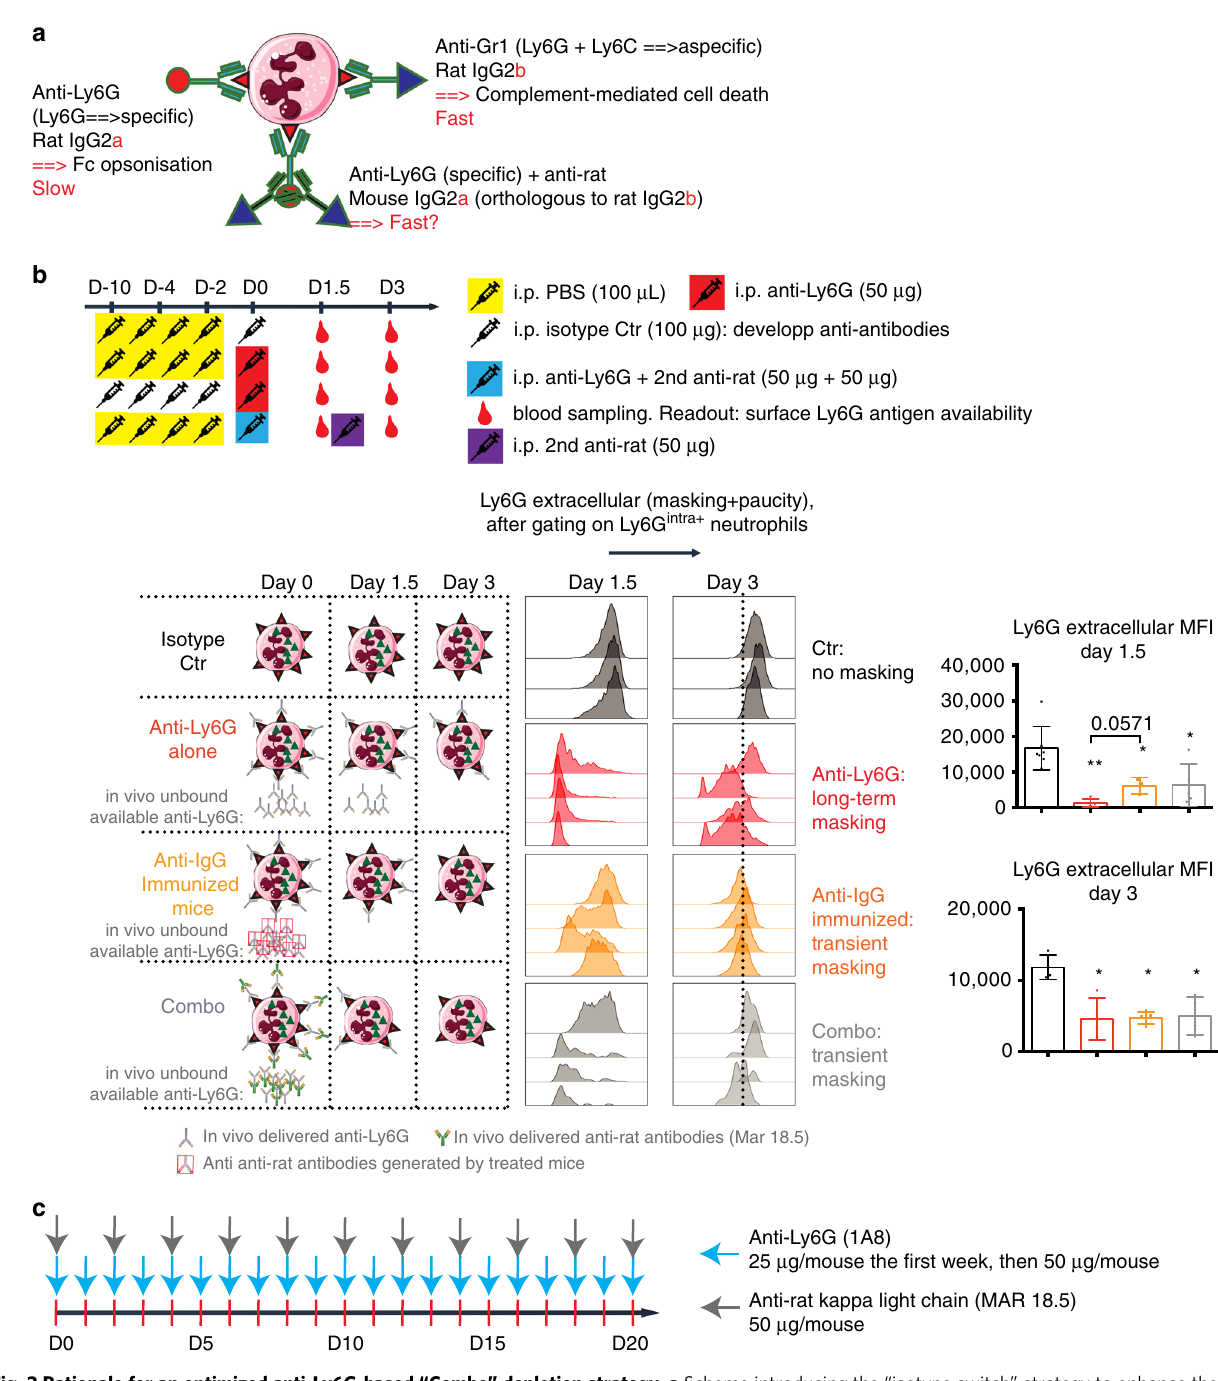
Fig. 3 Rationale for an optimized anti-Ly6G-based “ Combo ” depletion strategy. a Scheme introducing the “ isotype switch ” strategy to enhance the anti- Ly6G killing celerity. b Experimental plan to evaluate the impact of anti-antibodies on the ability of anti-Ly6G to bind the Ly6G antigen. Neutrophils from blood were gated as CD45 + CD11b + Ly6G intra + . The MFI of Ly6G extracellular was then measured. One can see that both anti-IgG immunized mice or mice treated with anti-Ly6G + anti-rat (MAR 18.5) antibodies have more Ly6G antigens available 1.5 days after anti-Ly6G injection. c According to the data obtained in ( b ), the ideal scheme for double antibody-based neutrophil depletion requires a daily injection of anti-Ly6G. * p < 0.05, ** p < 0.01 from Mann – Whitney test; error bars represent s.d. 5 – 7 control (Ctr) and 4 – 5 treated mice were used per group. Source data are provided as a Source Data fi reduced by the occurrence of anti-antibodies developed by treated mice. Additional experiments allowed us to diminish the dose of anti-Ly6G to 25 μ g to fully mask neutrophils even when mice were more than 30 g of weight. To spare a daily double injection on mice, we deliver the secondary antibody only once every other day according to our fi nal protocol named “ Combo ” (Fig. 3c).